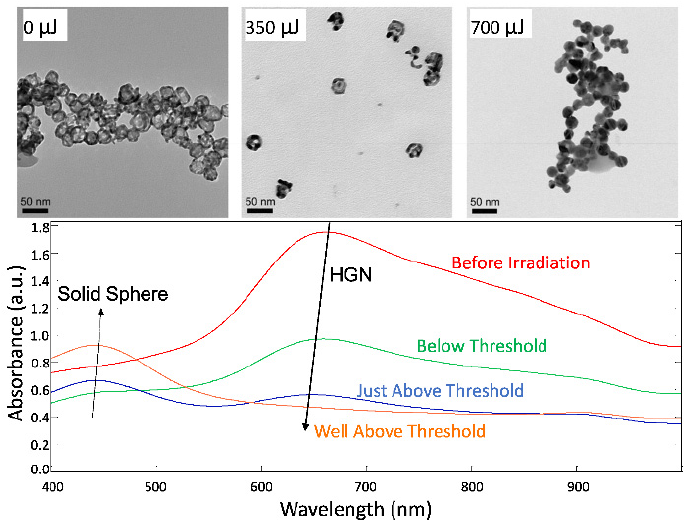
Figure 10. ( top ) TEM images of HGN following 0, 350, and 700 µJ pulse energy irradiation. The HGN evolve from hollow spherical shells to solid spheres following irradiation sufficient to induce nanobubbles. Adapted from [55], published by Wiley, 2008. ( bottom ) Optical spectra of HGN showing λ max of the LSPR peak at 700 nm decreases with increasing laser irradiation until this peak disappears well above the threshold laser intensity to induce nanobubble formation. A second LSPR grows in at λ max ~ 450 nm with increasing laser intensity, corresponding to the plasmon resonance of solid silver–gold alloy spheres. Adapted from [45], published by Wiley, 2018.